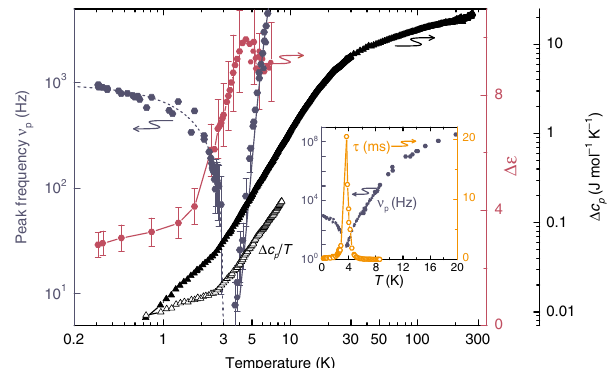
Fig. 3 Dielectric and thermodynamic indications of a phase transition at T = 3 K. Temperature dependences of peak frequency (dark blue circles) 0 and dielectric strength Δ ε (purple circles) of the relaxational excitation (Fig. 2) observed in the hydrous cordierite crystal for the polarization E || a . The dark blue lines correspond to the fi ts according to ~ exp{ − E a / k B T }*( T − T E = 6.2 meV above T T = 3 K; solid line) and ~ ( T − T ) below 0 ) with a 0 ( 0 0 T 0 (dashed line), as described in the text. The solid black triangles show the temperature dependence of the excess speci fi c heat of water molecules hosted by cordierite. Δ c p is calculated as difference between the speci fi c heat of hydrated and dehydrated crystals. The open black triangles show the speci fi c heat plotted as Δ c p / T to stress the low-temperature part. Inset: temperature dependences of the peak frequency ν p of the excitation and of the dipole relaxation time τ = (2 π ν p ) − 1 in a linear temperature scale. The error bars correspond to the ranges of the data that provide satisfactory description of the temperature-dependent relaxational excitation seen in the spectra of the complex = − 15 C